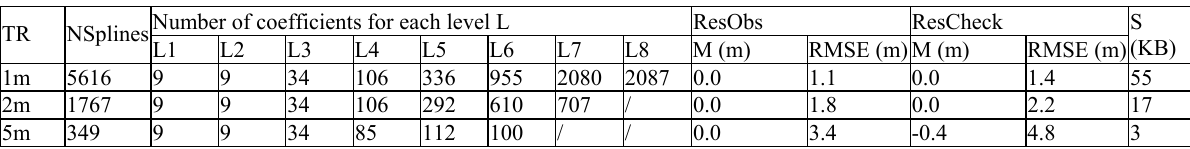
Table 5. Statistics of DTM MR . TR: interpolated TIN. NSplines: total number of activated splines. ResObs, ResCheck: statistics of the